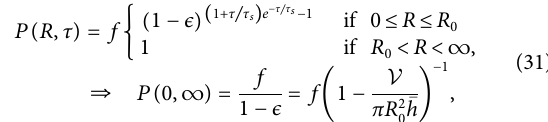
(cid:1) h ) is given in 0